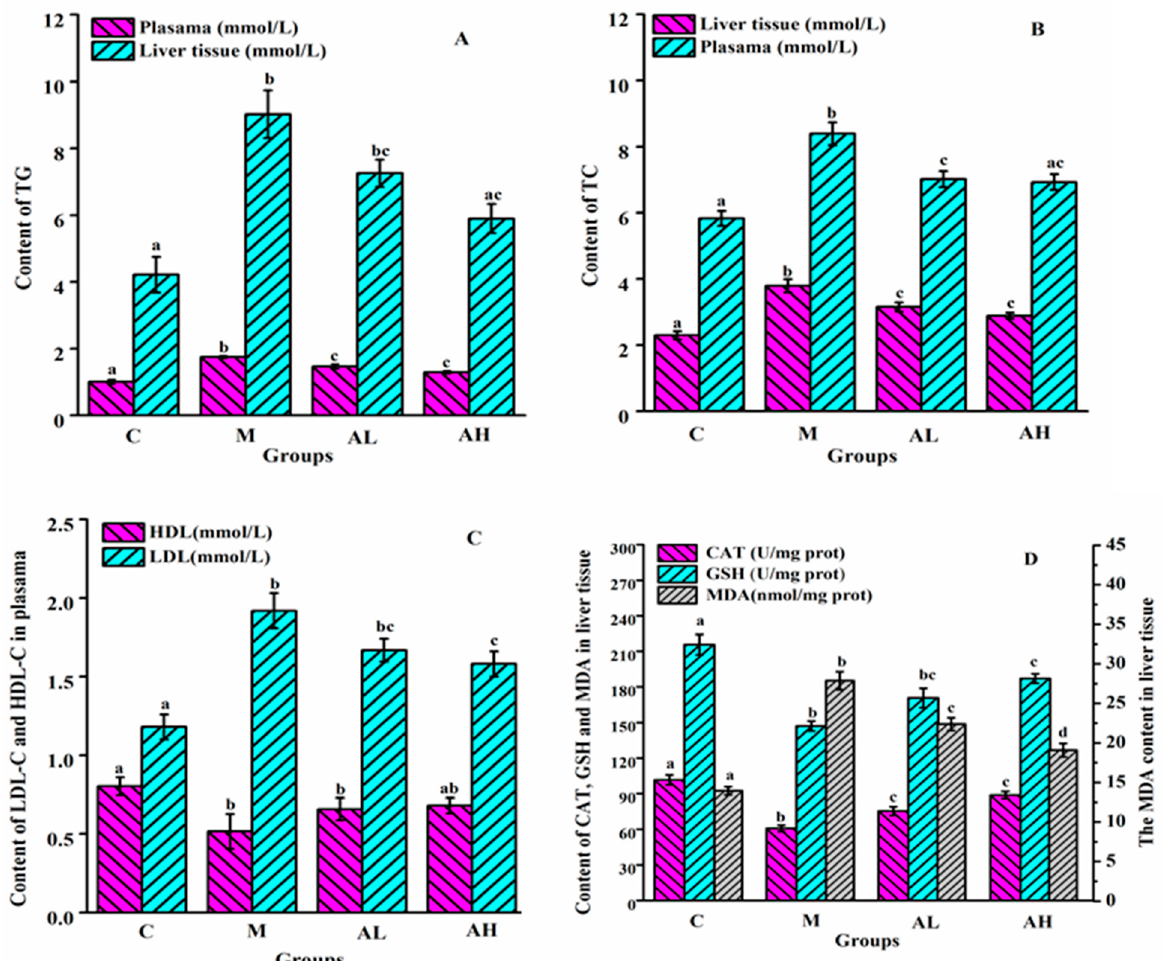
Figure 1. Effects of ethanol extract from R. chinensis Mill. fruits on the biochemical parameters of plasma and liver tissue induced by a high fat/high sugar diet. ( A ) Triglyceride (TG)contents in plasma and liver tissue. ( B ) Total cholesterol (TC) contents in plasma and liver tissue. ( C ) Low-density lipoprotein cholesterol (LDL-C) and High-density lipoprotein cholesterol (HDL-C) contents in plasma. ( D ) Catalase (CAT), Reduced glutathione (GSH) and Malondialdehyde (MDA) contents in liver tissue. C: Control group, M: Model group, AL: Low dose ethanol extract group (200 mg/kg), AH: High dose ethanol extract group (600 mg/kg). Data were expressed as the mean ± SE ( n = 6). Different letters indicate significant differences ( p < 0.05).